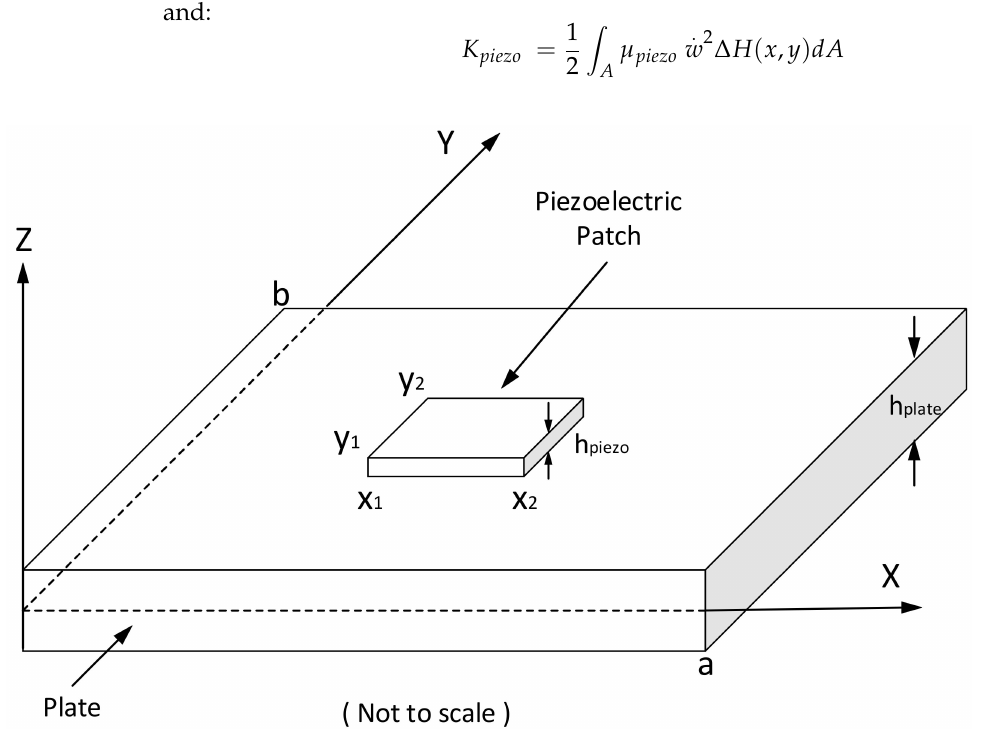
Figure 1. The dynamic system of the thin